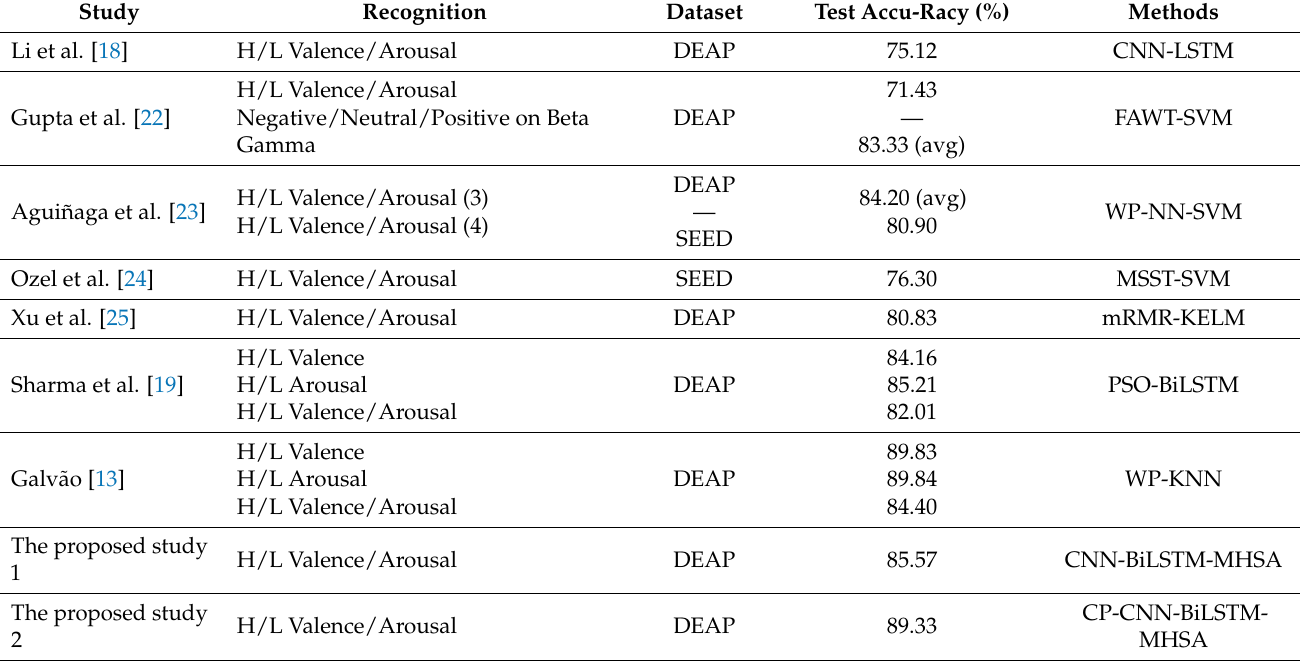
Table 9. Comparison with previous four-classification